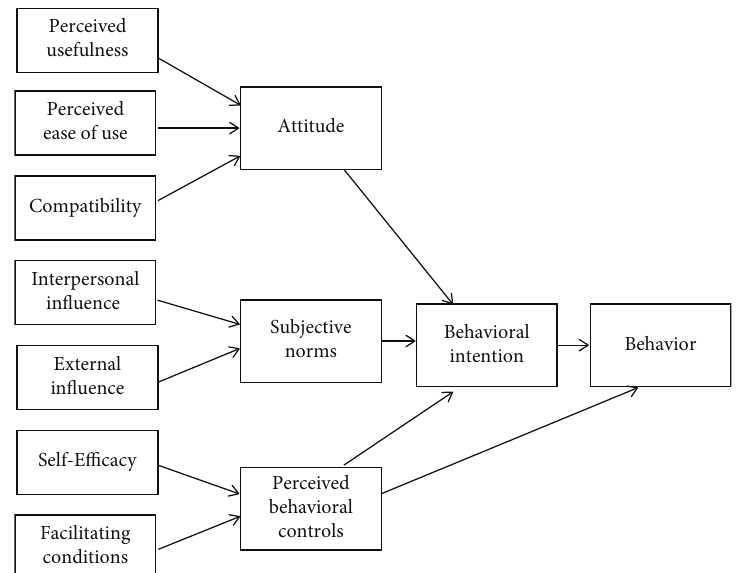
Figure 8: Decomposed theory of planned behavior [32].